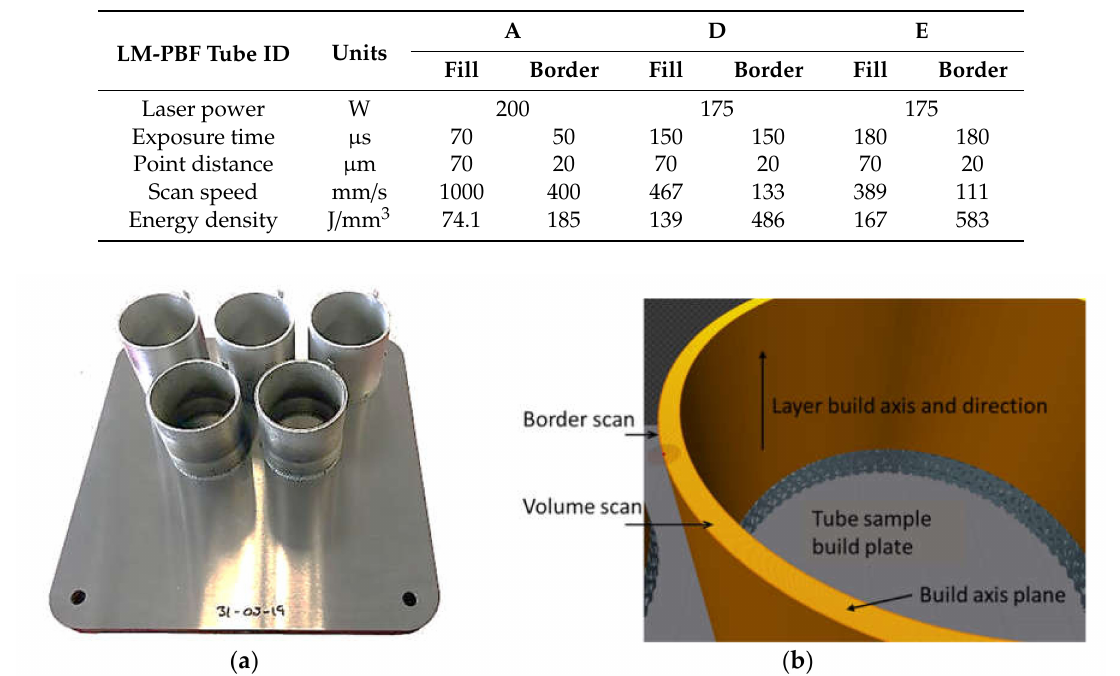
Table 1. AM processing parameters used for the laser melting powder bed fusion (LM-PBF) of tube samples A, D, and E.